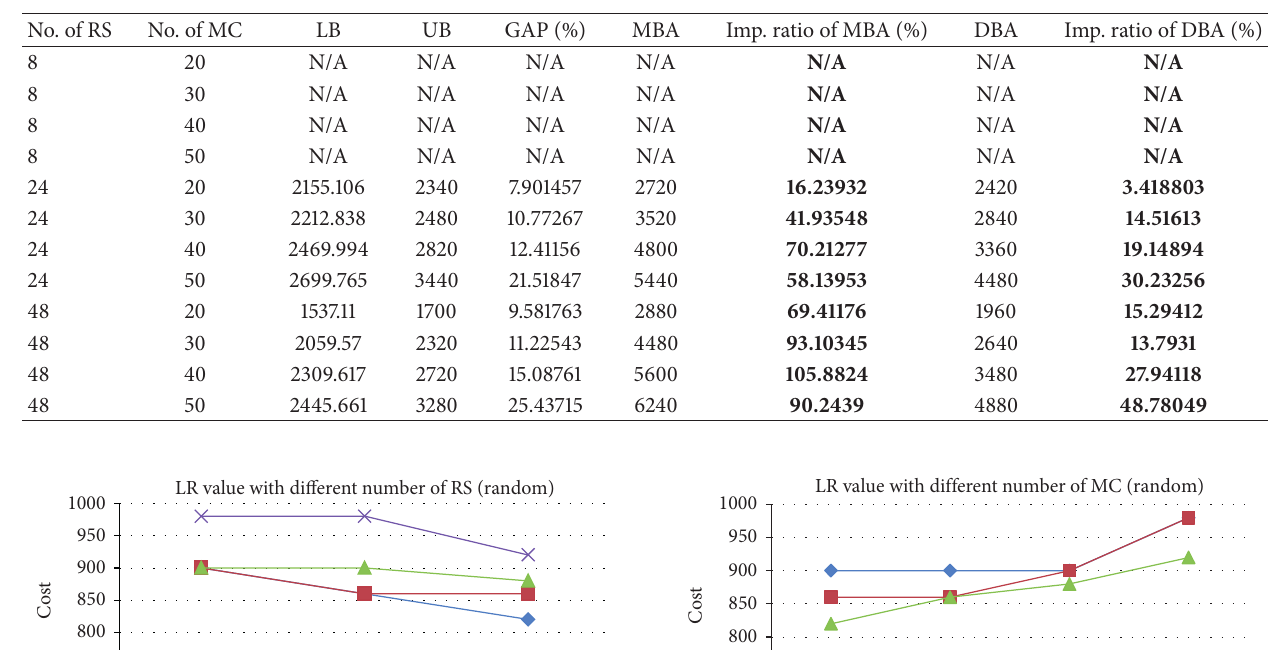
Table 9: Experiment results (1BS, grid, 6.4km).